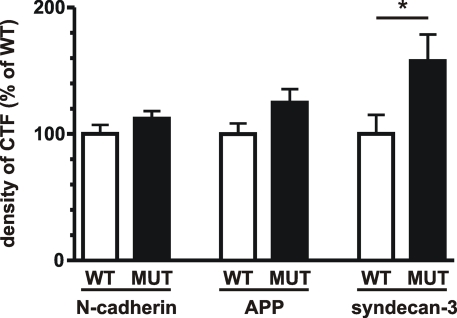
γ-Secretase cleavage activity of human wild-type APH1B (Phe217) and human mutant APH1B (Leu217) stably transfected into Aph1abc−/− mouse embryonic fibroblast cells.The levels of the C-terminal fragments (CTFs) of N-cadherin, APP and syndecan 3 were analysed in cells stably transfected with human APH1B Phe217 (WT) or human APH1B Leu217 (MUT). In the MUT cells, the CTF levels of N-cadherin and APP were slightly increased (1.1-fold and 1.2-fold, respectively), but the difference failed to reach significance. The levels of syndecan-3-CTF were significantly increased (1.6-fold; p = 0.044), indicating a reduced γ-secretase cleavage activity. Bars represent quantifications of CTF signals normalized to full-length protein levels in eight stably transfected cell lines with the average level in WT cell lines set to 100%. *: p<0.05.